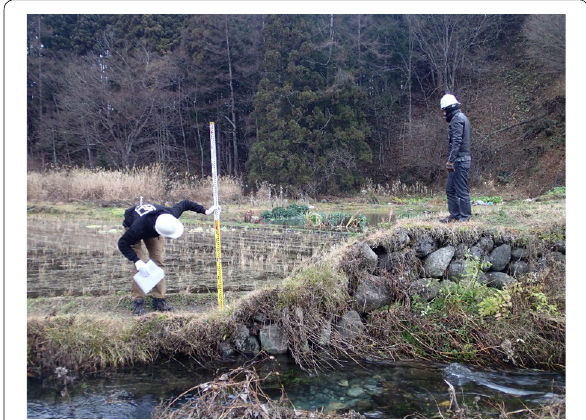
Fig. 2 An example of coseismic surface offset due to reverse faulting. Photograph taken at a site called Joyama located in the central part of the focal area. View from the south